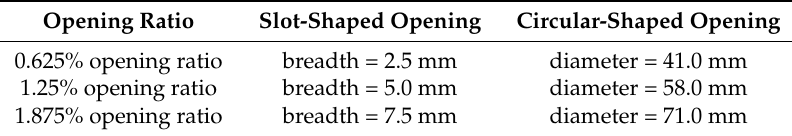
Table 1. Geometric parameters of the six tested top openings.